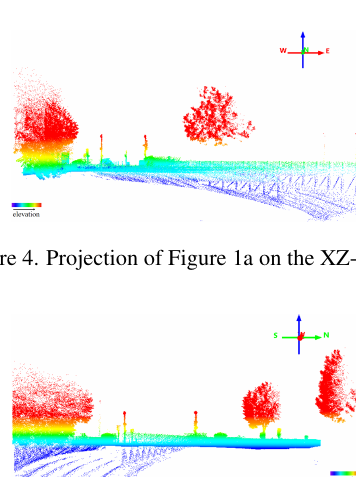
Figure 3. Projection of Figure 1a on the XY-plane.